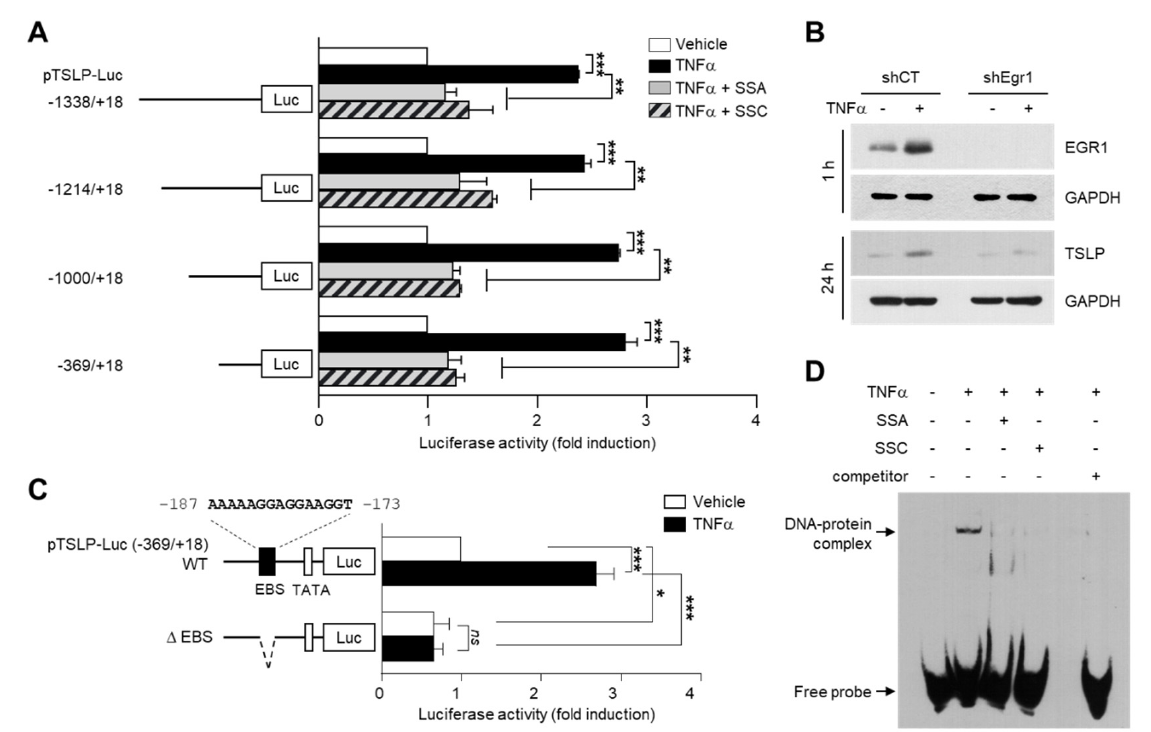
Figure 4. Role of EGR1 in TNF- α -induced TSLP transcription. ( A ) HaCaT cells were transfected with 0.2 µg of a series of 5’-deletion constructs of the TSLP promoter. After 24 h, the cells were treated with 10 ng/mL of TNF- α in the absence or presence of 1 µM SSA or 20 µM SSC for an additional 8 h, and luciferase promoter-reporter activities were measured. ( B ) Immunoblotting was performed to examine the effects of control scrambled shRNA (shCT) and EGR1-specific shRNA (shEgr1) on TNF- α -induced EGR1 and TSLP protein expression. ( C ) HaCaT cells were transfected with wild-type and EBS-deleted pTSLP-Luc ( − 369/+18) plasmid. After 24 h, the cells were stimulated with TNF- α (10 ng/mL) for an additional 8 h, and luciferase activities were analyzed. ( D ) HaCaT cells were treated with TNF- α (10 ng/mL) in the absence or presence of SSA (1 µM) or SSC (20 µM). After 1 h, nuclear extracts (3 µg) were incubated with a biotinylated EGR1-binding oligonucleotide probe (50 fmol) in the absence or presence of an unlabeled probe (competitor, 2500 fmol). Data are expressed as means ± SD ( n = 3). * p < 0.1, ** p < 0.01, *** p < 0.001 by Sidak’s multiple comparisons test. WT, wild-type; ∆ EBS, deletion of EGR1-binding sequence from − 187 to −